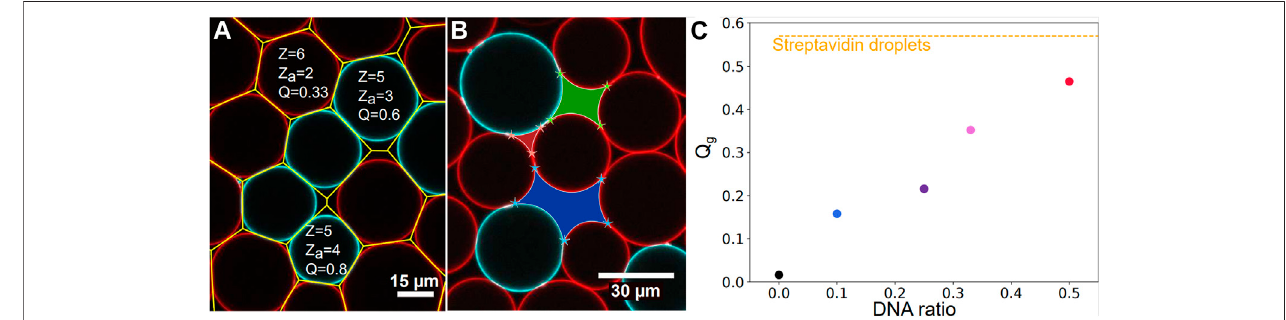
FIGURE 2 | Image analysis — (A) Surface Voronoi analysis (yellow lines) of a packing of complementary droplets coated with C (red droplets) and D (blue droplets) DNA sequences. Local coordination, number ofadhesive contact and the resulting adhesiveness aregiven asan examplefor three droplets in the packing. The number ofadhesivecontacts z a isheregivenbythenumberofsurroundingdropletsexhibitingacomplementarycolortothecentraldropletandalocalincreasein fl uorescenceat the contact site with the central droplet. (B) Illustration of void analysis displaying a 3-sided (red), a 4-sided (green) and a 5-sided (blue) void in a DNA droplets packing. (C) Globaladhesiveness Q g calculatedoveralldropletsinallimagesacquiredasafunctionofthechosenratioofcomplementaryDNAdroplets. Q g growsasthe ratio is increased from 1:9 to 1:1. The global adhesiveness calculated for the streptavidin packings Q g (cid:1) 57 % is shown with the yellow dashed